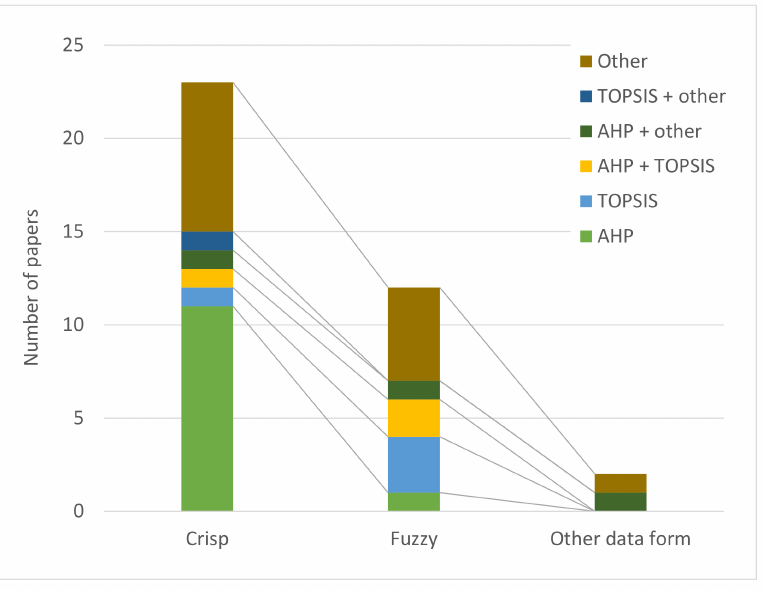
Figure 2. Distribution of data representation forms in the reviewed